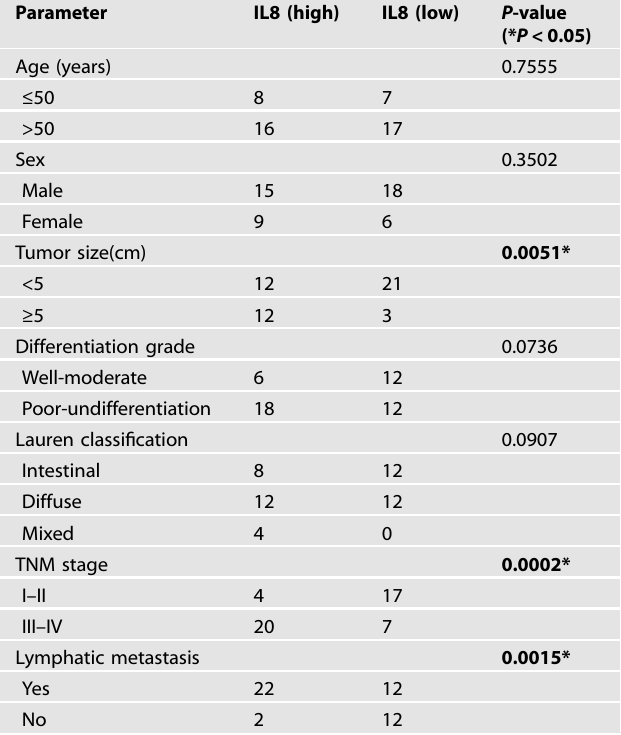
Table 1. Correlation between IL8 expression and clinicopathological features of GC ( n =